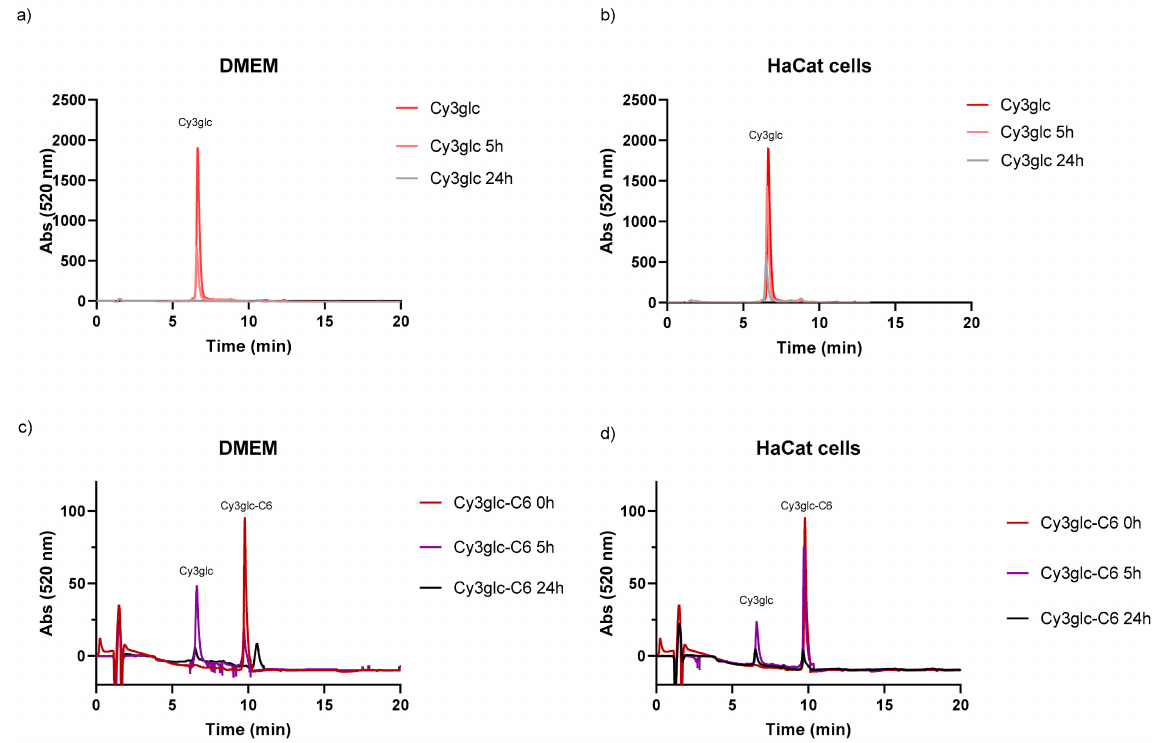
Figure 2. Physiological stability of Cy3glc and Cy3glc-C6 was performed in DMEM 10% FBS in the presence ( b , d ) or absence ( a , c ) of HaCat cells, at pH 7.4 at 37 ◦ C, during 5 and 24 h. Representative chromatograms at 520